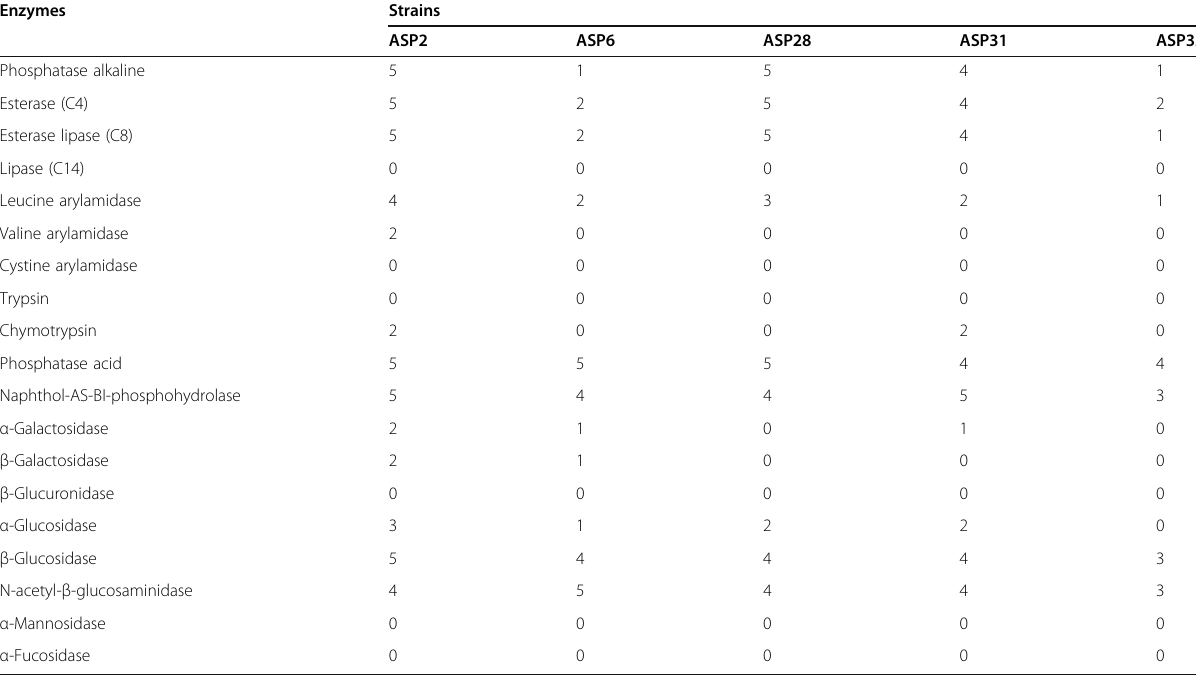
Table 2 Enzymes released by Aspergillus niger detected by the APY-ZYM® system Enzymes